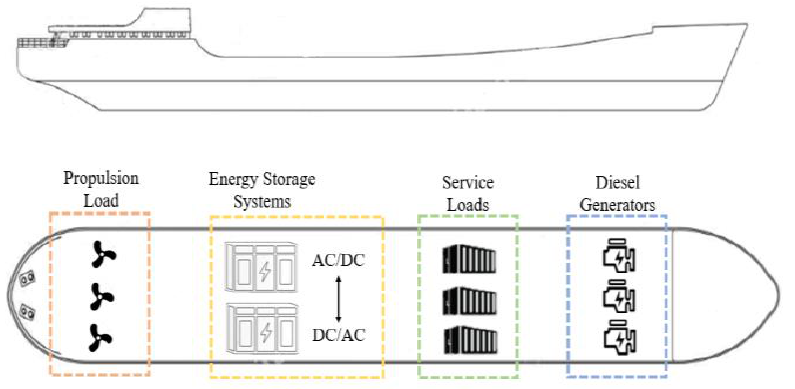
Figure 1. Hybrid ship composition.